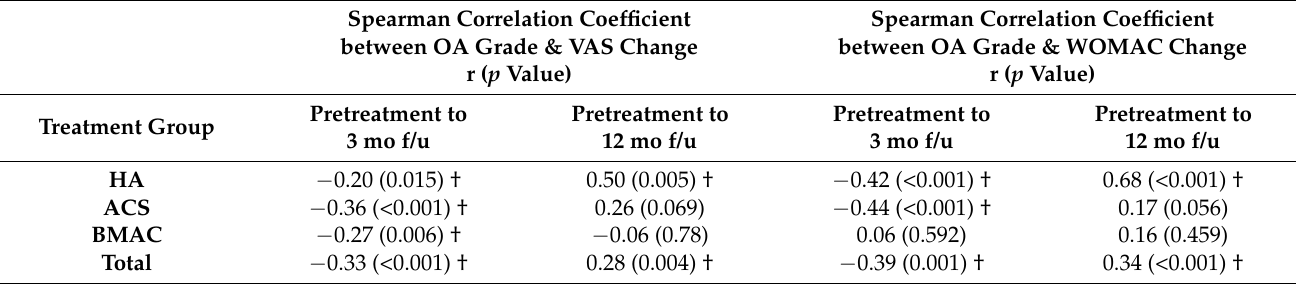
Table 6. Correlation between grade of OA and change in VAS and WOMAC score over the follow-up period. Spearman Correlation Coefficient between OA Grade & WOMAC Change between OA Grade & VAS Change r ( p Value) r ( p Value)